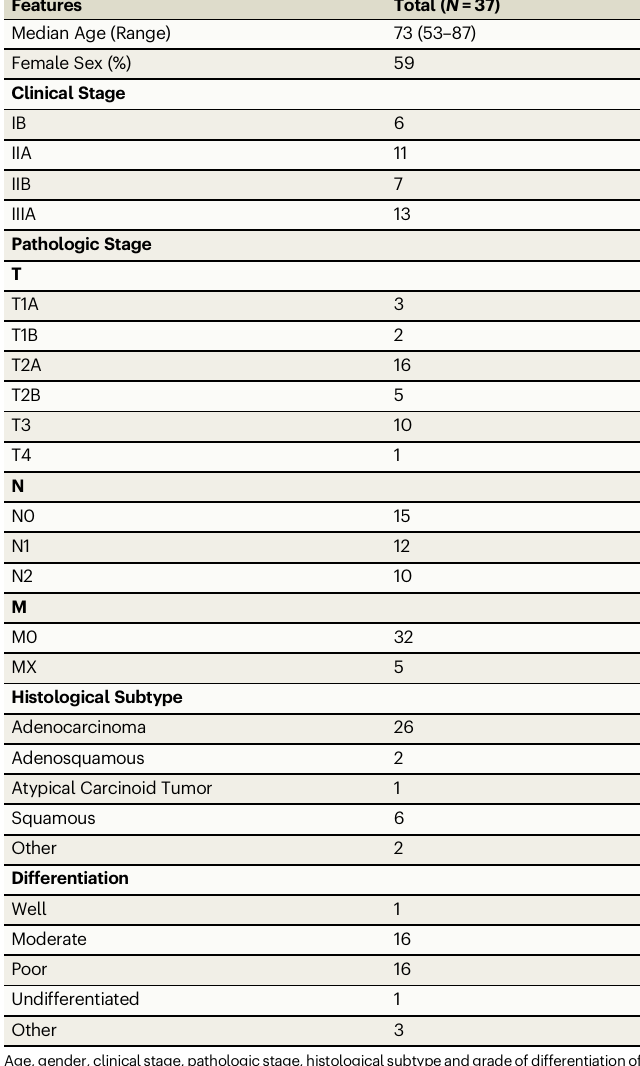
Table 2 | Clinical demographics and tumor characteristics